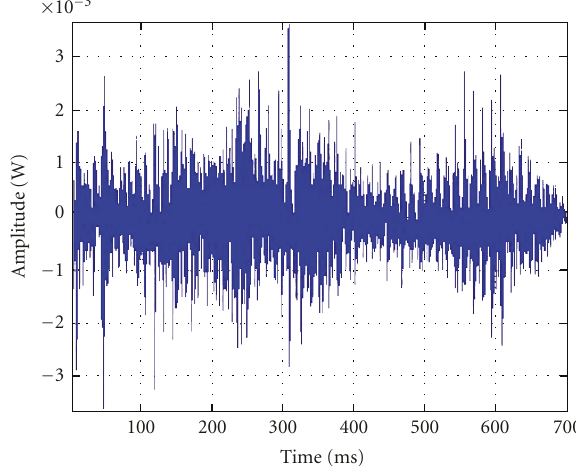
Figure 2: Vocal signal amplitude versus time